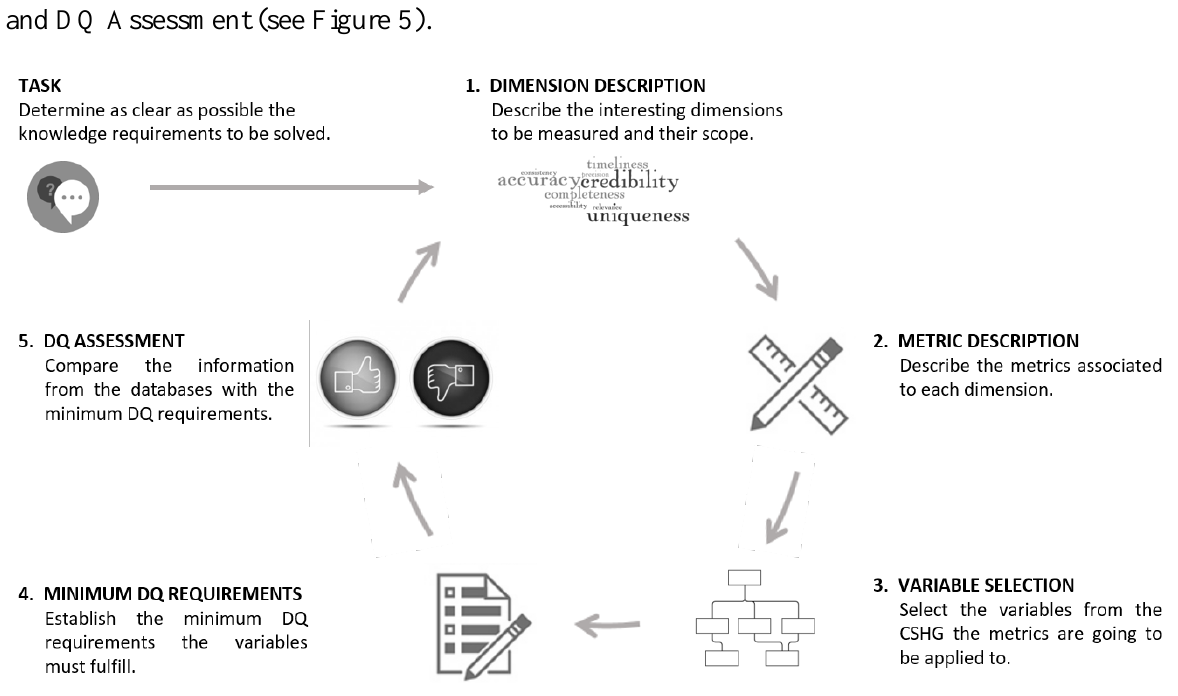
Figure 5. Proposed Data Quality Methodology to ensure the veracity and value of the